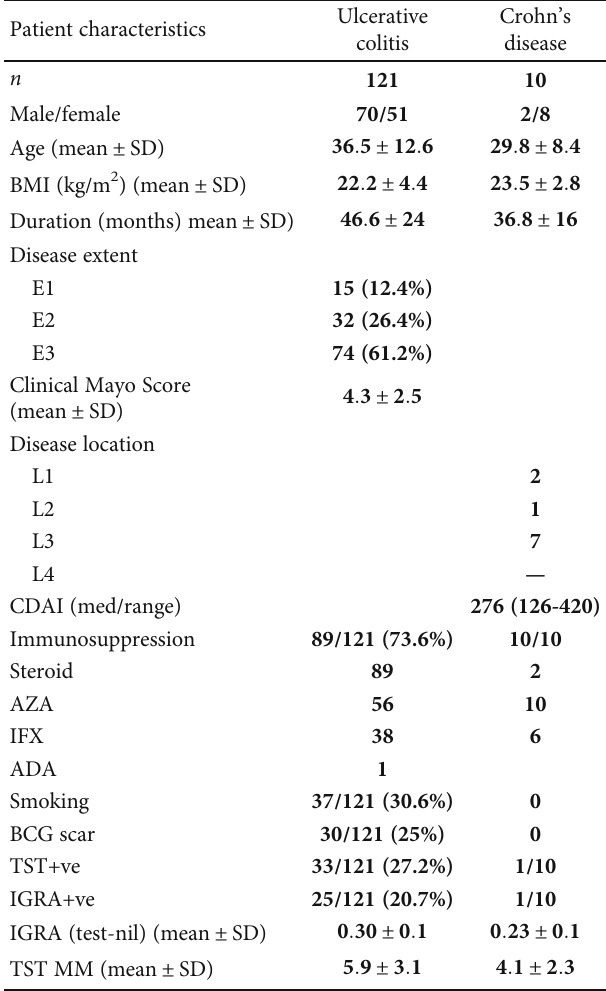
Table 1: Various demographic and clinical characteristics of IBD